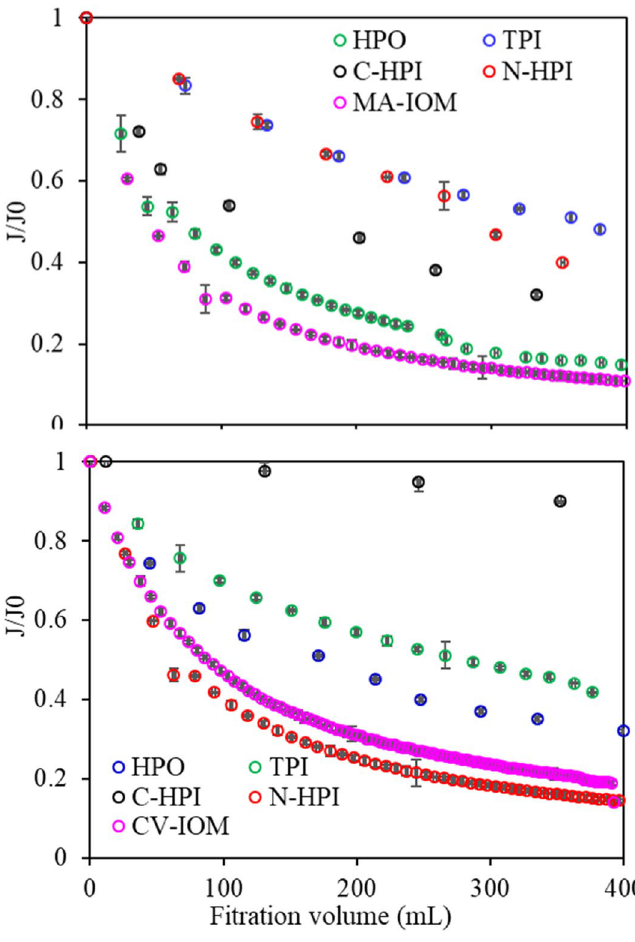
Figure 2. Variation of filtration flux of various IOM fractions (DOC 5 ± 0.05 mg/L, pH 7.0).